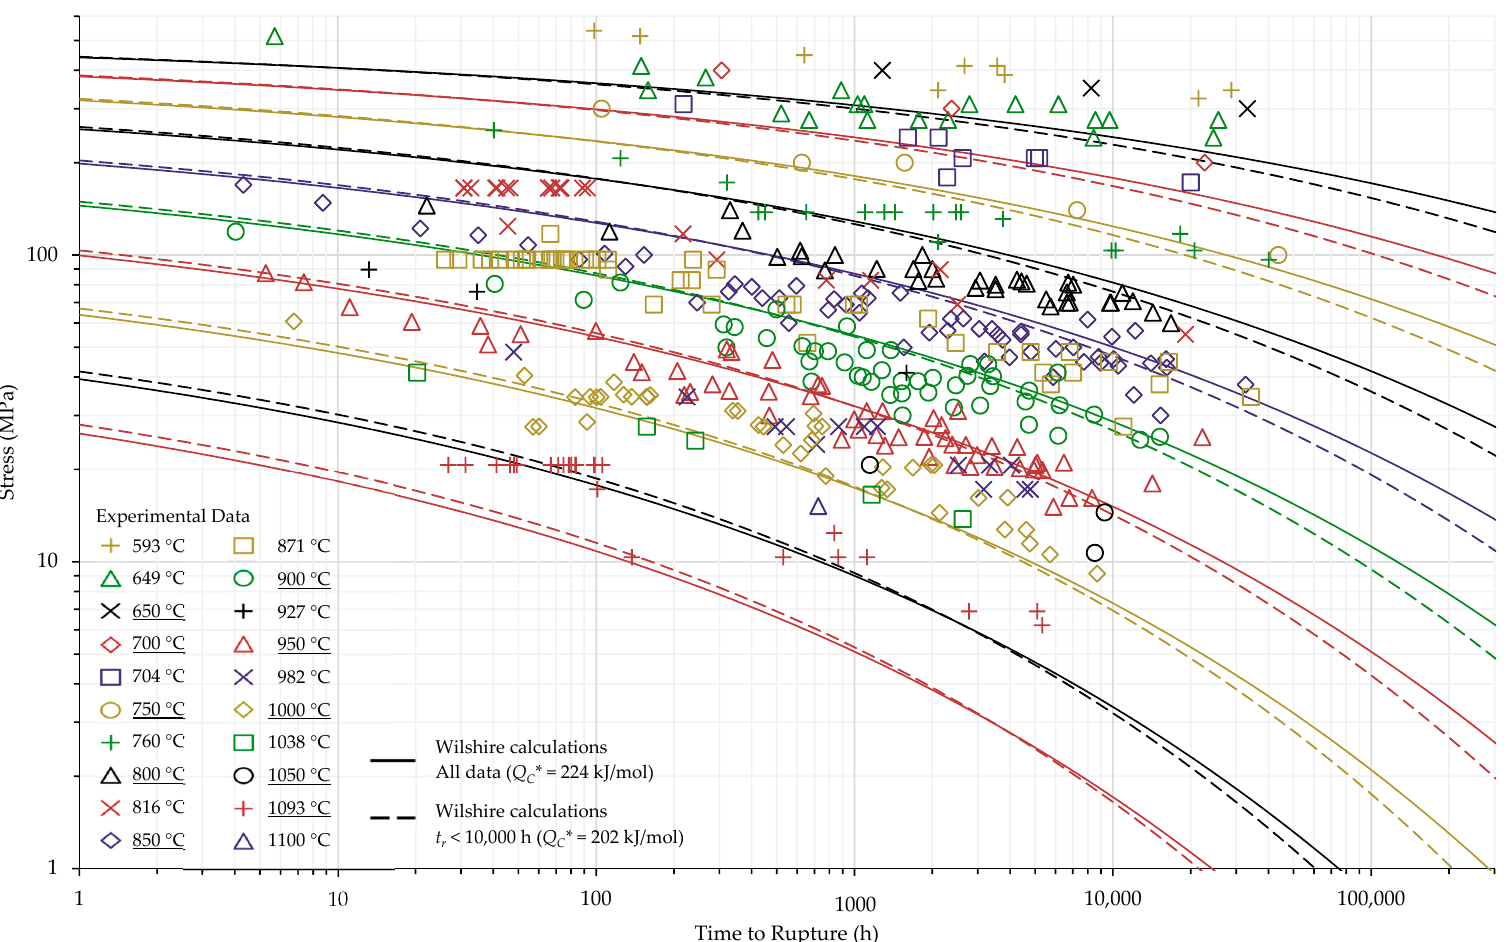
Figure A7. Single region calculations of the Wilshire equation with Q ∗ determined by optimizing the correlation of data on a Wilshire plot for Inconel 617 shown underlined at underlined temperatures.